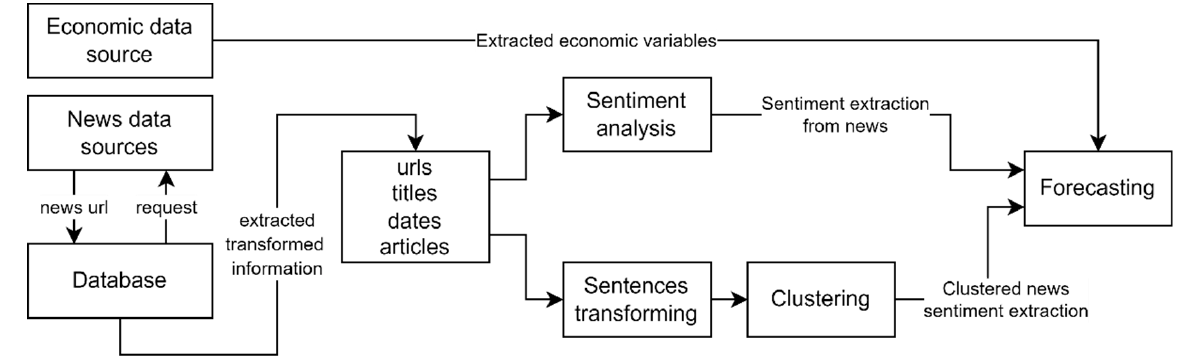
Figure 2. Basic simplified scheme of research.